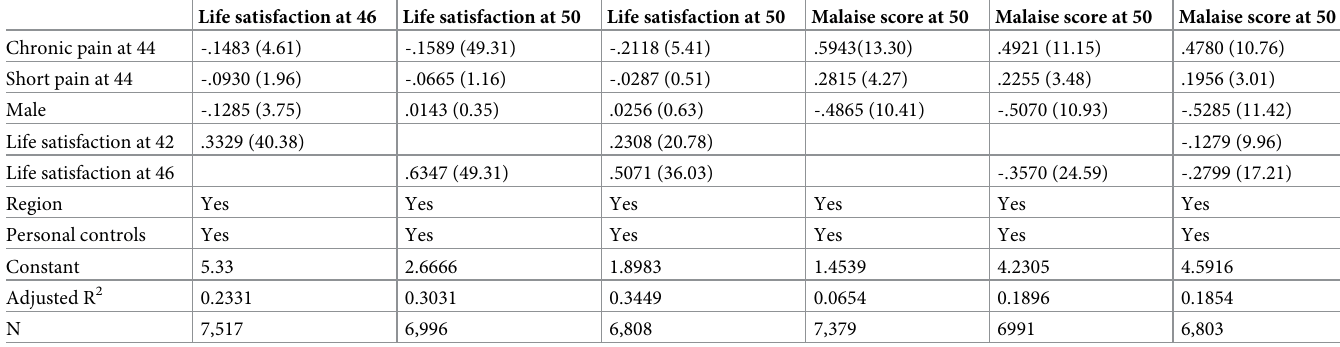
Table 15. Life satisfaction and malaise scores in NCDS7 at 46 and NCDS8 at 50 (OLS). Life satisfaction at